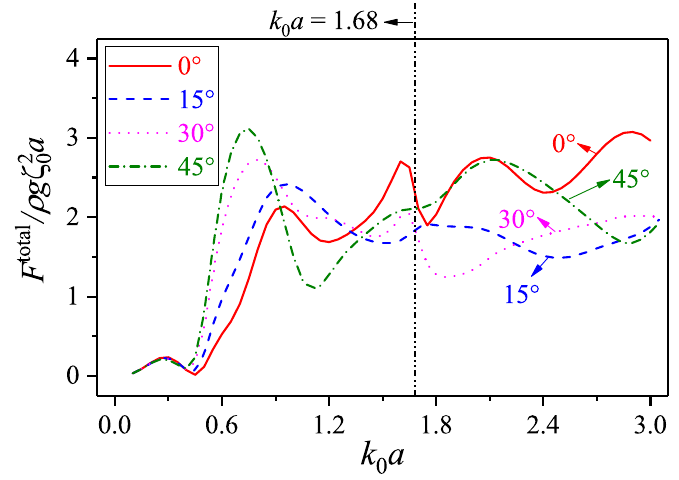
Figure 12. The total wave drift forces on the whole structure with different wave-approach angles.